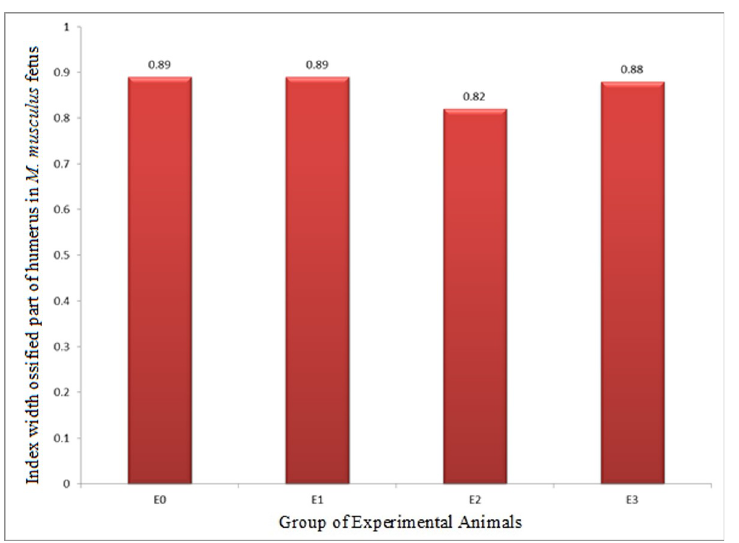
Fig 7. Index of width of ossified part (growth in diameter, IWOP) of humerus in M . musculus fetuses on gestation day (GD) 18 which previously were given 0.39 mg/g bw LE3H through gavage on GD 10 (E1), injected with 5 mg/ kg bw HgCl 2 on GD 9 (E2), and administered 5 mg/kg bw HgCl 2 on GD 9 and then 0.39 mg/g bw LE3H on GD 10 (E3). Meanwhile, the controls (E0) were administered double-distilled water